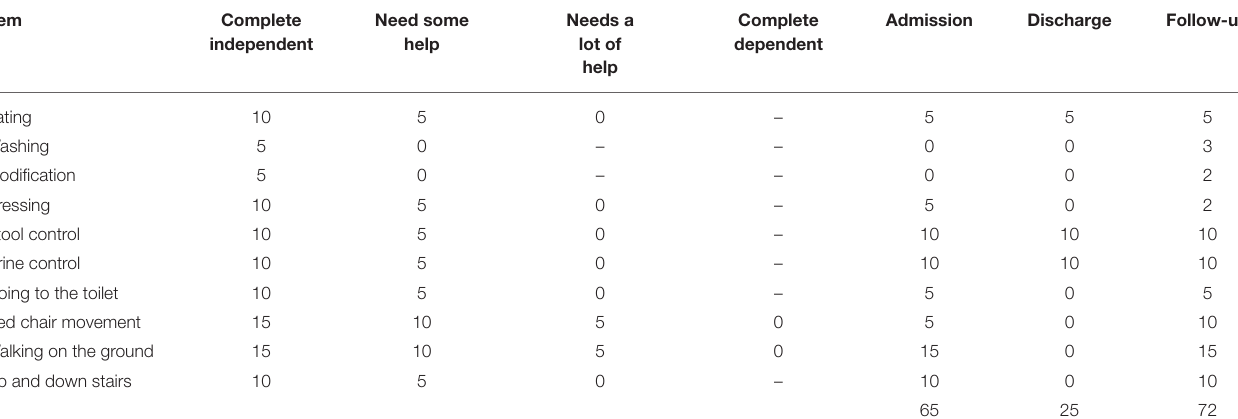
TABLE 1 | Activity of daily living